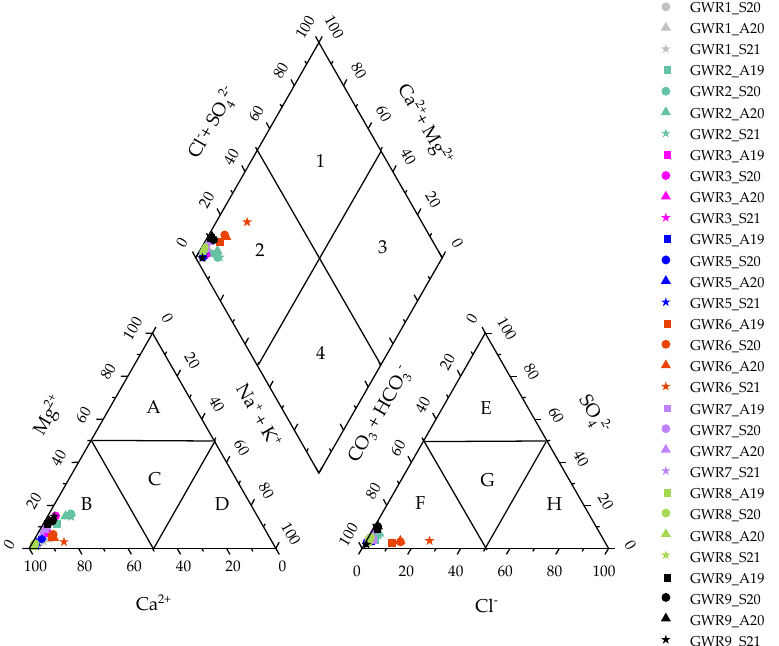
Figure 2. Piper diagram of the studied spring waters as well as the dominant cation and anion fields (A-Magnesium type; B-Calcium type; C-No dominant type; D-Sodium type; E-Sulfate type; F- Bicarbonate type; G-No dominant type; H-Calcium, Magnesium bicarbonate type) and the hydrochemical facies (1-Calcium, magnesium sulfate; 2-Calcium, magnesium bicarbonate; 3- Sodium chloride; 4- Sodium